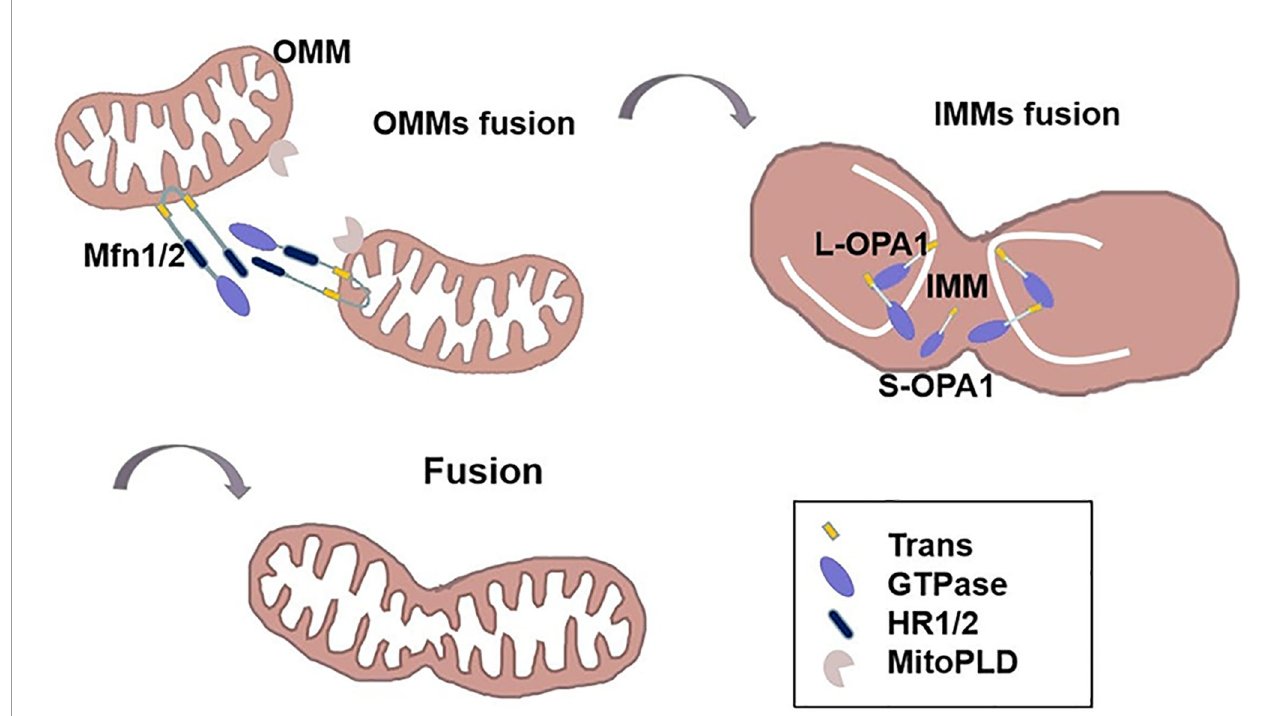
FIGURE 2 | The mechanism of mitochondrial fusion. The HR2 domain of Mfn1/2 constitute an anti-parallel coiled coil and ties the OMMs together in trans. MitoPLD can bring the membranes closer together. Then, GTP hydrolysis triggers a massive conformational rearrangement of Mitofusin, placing two OMMs together. Following outer membrane fusion, L-OPA1 is anchored to the mitochondrial inner membrane, transient head-to-tail assembly of L-OPA1 induces membrane curvature that producing unstable tips on two opposing IMMs. After GTP of L-OPA1 hydrolysis, IMMS fused together. S-OPA1 is located at the mitochondrial intermembrane